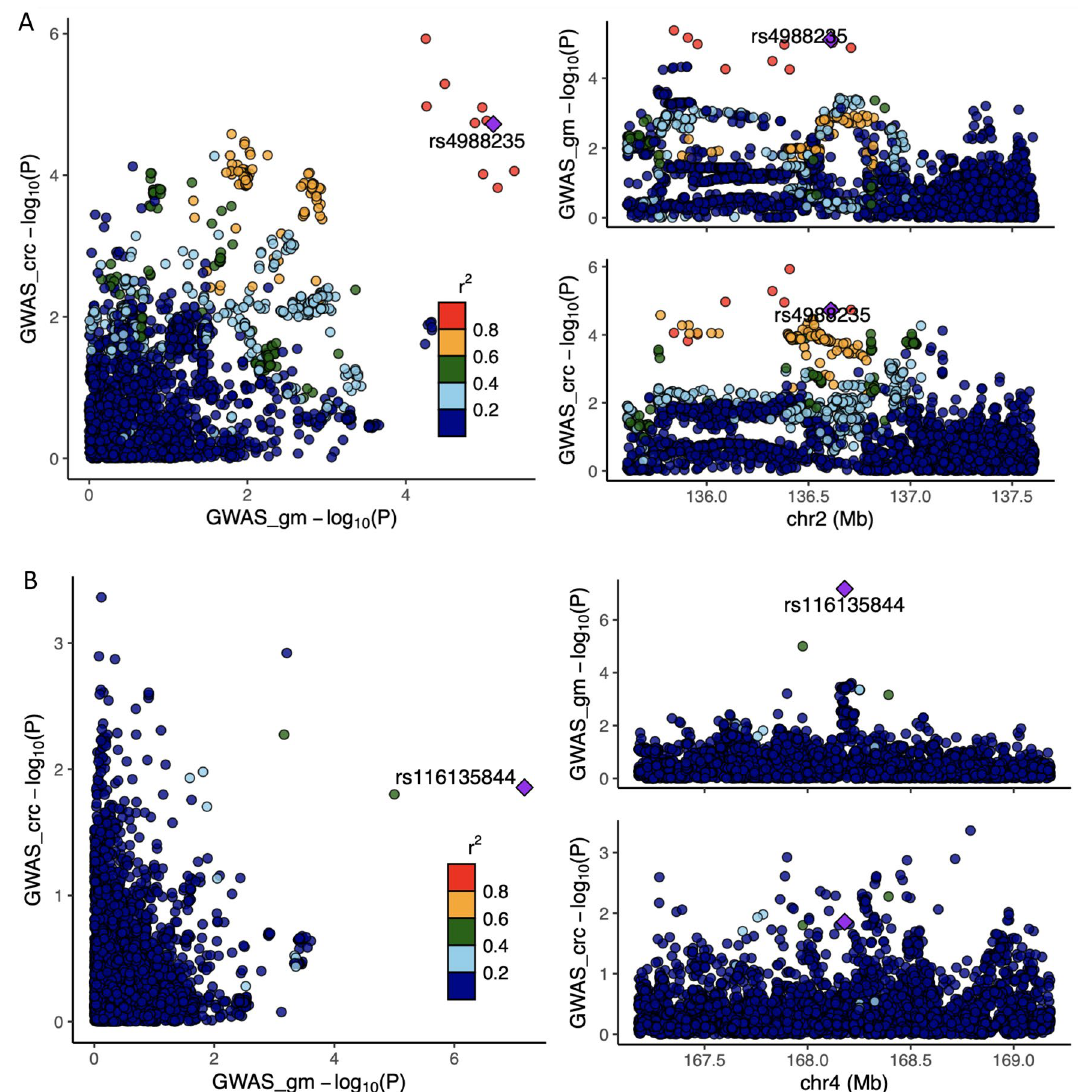
Figure 3. Colocalisation results for bacteria within the ( A ) Bifidobacterium AB microbial trait and ( B ) P / A of unclassified genera within the Bacteroidales order with overall CRC. AB = abundance; CRC = colorectal cancer; FGFP = Flemish Gut Flora Project; GECCO = Genetics and Epidemiology of Colorectal Cancer Consortium; GM = gut microbiome; GWAS = genome-wide association study; P/A = presence versus absence. Regional association plots, generated from LocusCompareR, showing the − log10( P -value) where each lead SNP is represented by a purple diamond (panel A: rs4988235 associated with the Bifidobacterium AB microbial trait and panel B: rs116135844 associated with the unclassified Bacteroidales P/A microbial trait) in relation to overall CRC. These plots were created using the FGFP and GECCO full summary-level data for microbial traits and CRC,